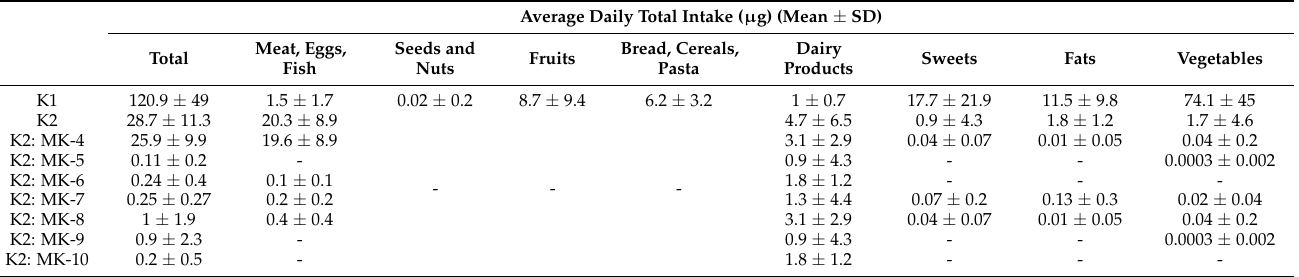
Table 1. The intake of vitamins K1 and K2 and its isoforms: MK4–MK10 in consumed product groups by kidney transplant